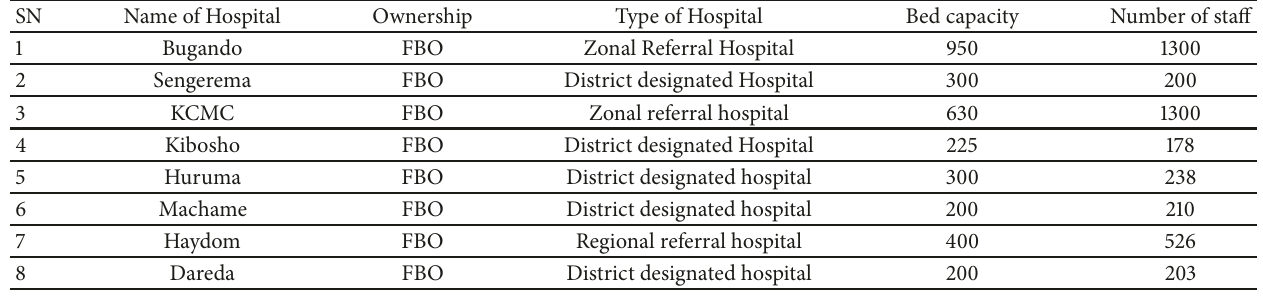
Table 2: Showing the name of teaching hospitals, type of hospital, ownership, bed capacity, and number of staff.